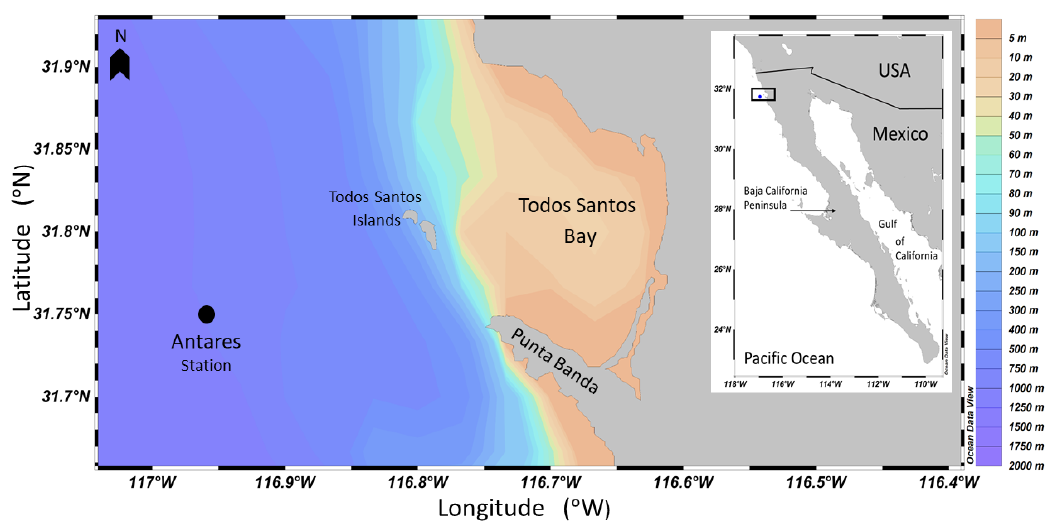
Figure 1. Location of the study site (Antares station). A regional view of the study area is shown to the right.